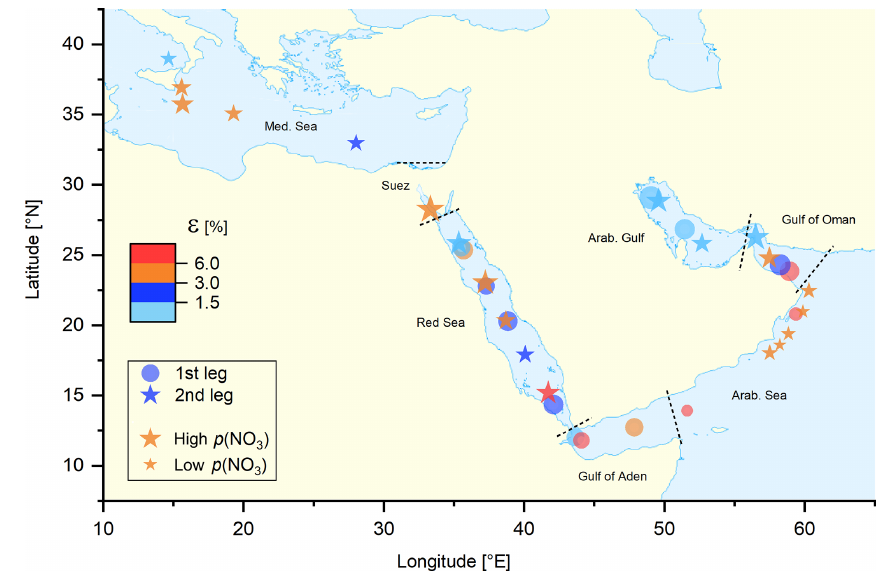
Figure 5. Median night-time values of ε (the ClNO 2 yield per NO 3 molecule formed) calculated via Eq. (4). The size of the symbols represents (logarithmic scale) the median NO 3 production rate, p (NO 3 ), ranging from 0.001pptvs − 1 in the Arabian Sea to 1.2pptvs − 1 in the Suez Canal. Different regions are separated by the dashed black lines.